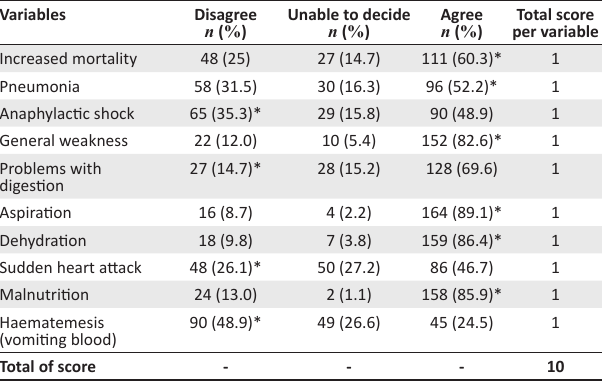
TABLE 3: Participants’ responses on their knowledge of the complications ( n = 184).